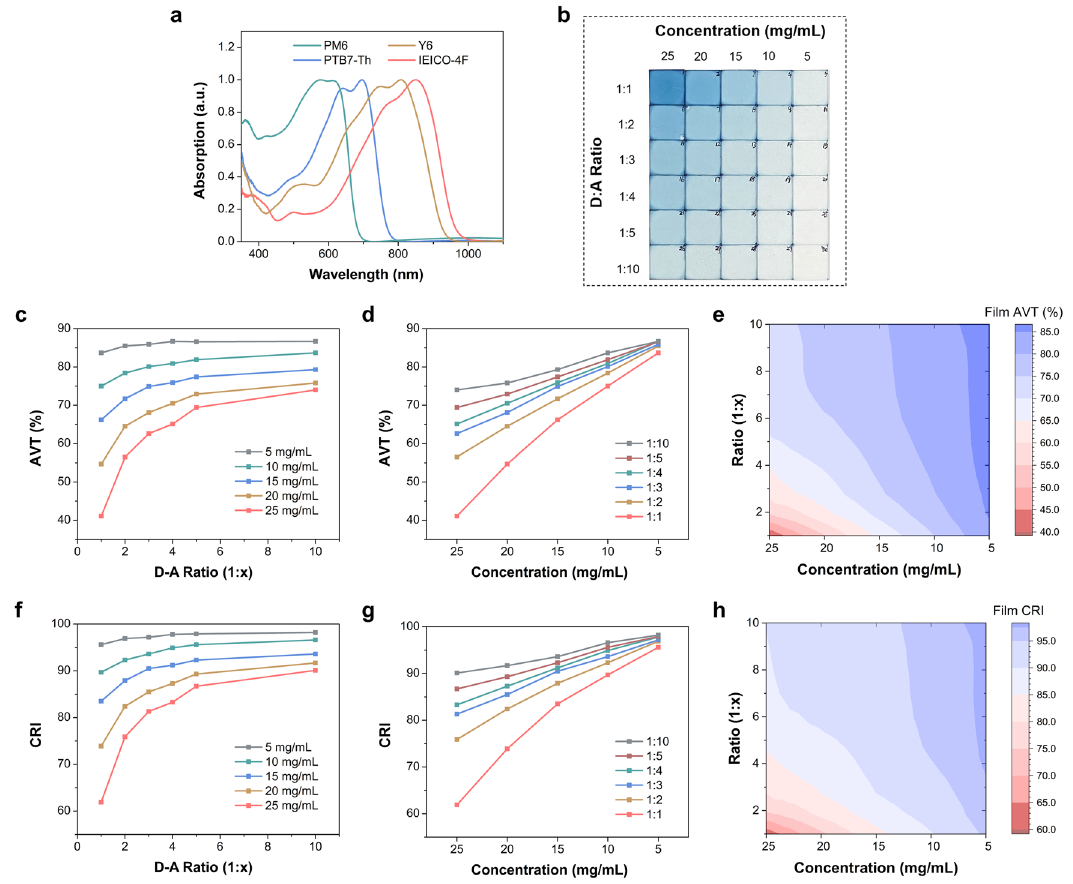
Fig. 1 Film optical properties. a Absorption spectra of the different donor and acceptor fi lms. b Photograph of BHJ fi lms which prepared with various D – A ratios or precursor concentrations on the glass substrate. c – h AVT, CRI values and models of the BHJ fi lms prepared with various D – A ratios or precursor